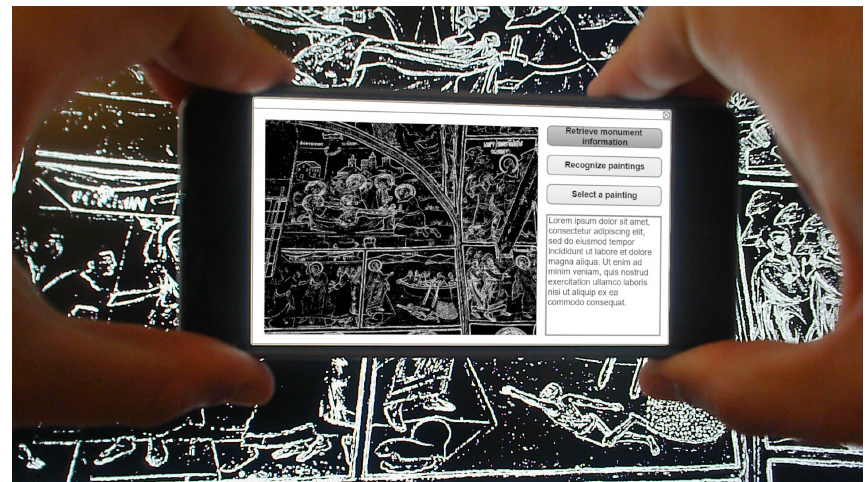
Figure 4. Inner UI Layer